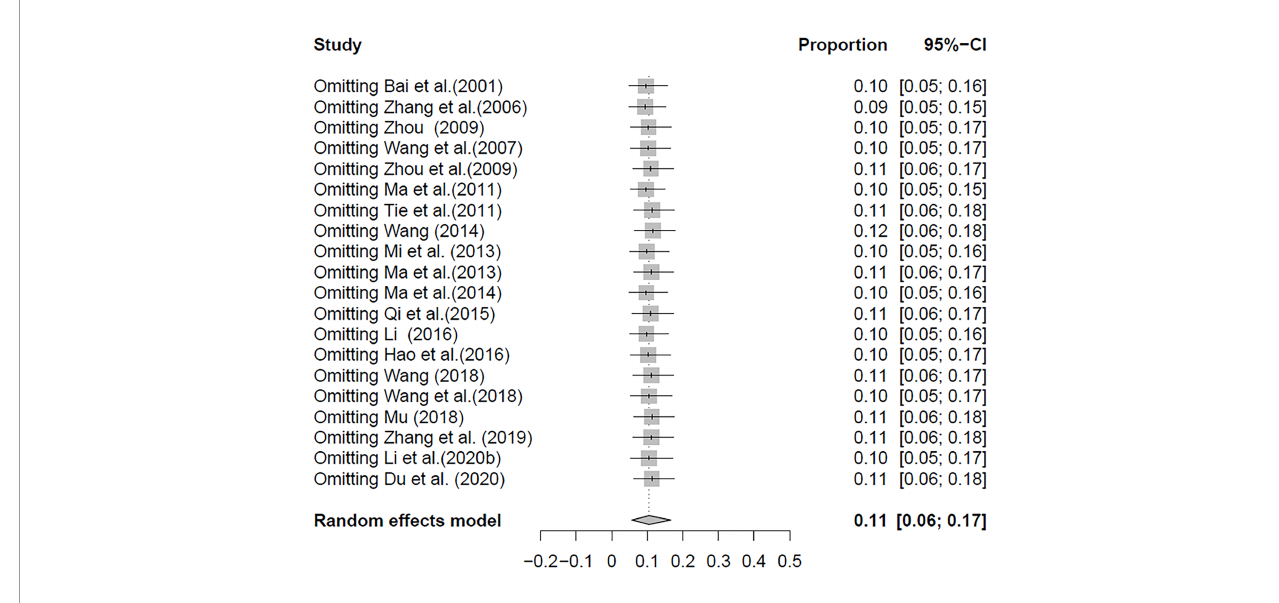
FIGURE 6 | Sensitivity